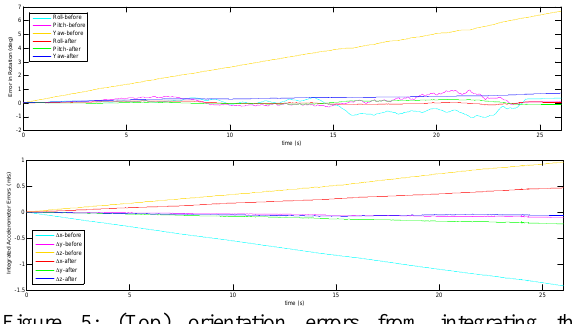
Figure 5: (Top) orientation errors from integrating the gyroscope signal; (Bottom) accelerometer errors from integrating the accelerometer signal in a rotating frame before and after in-situ self-calibration without CUPT.